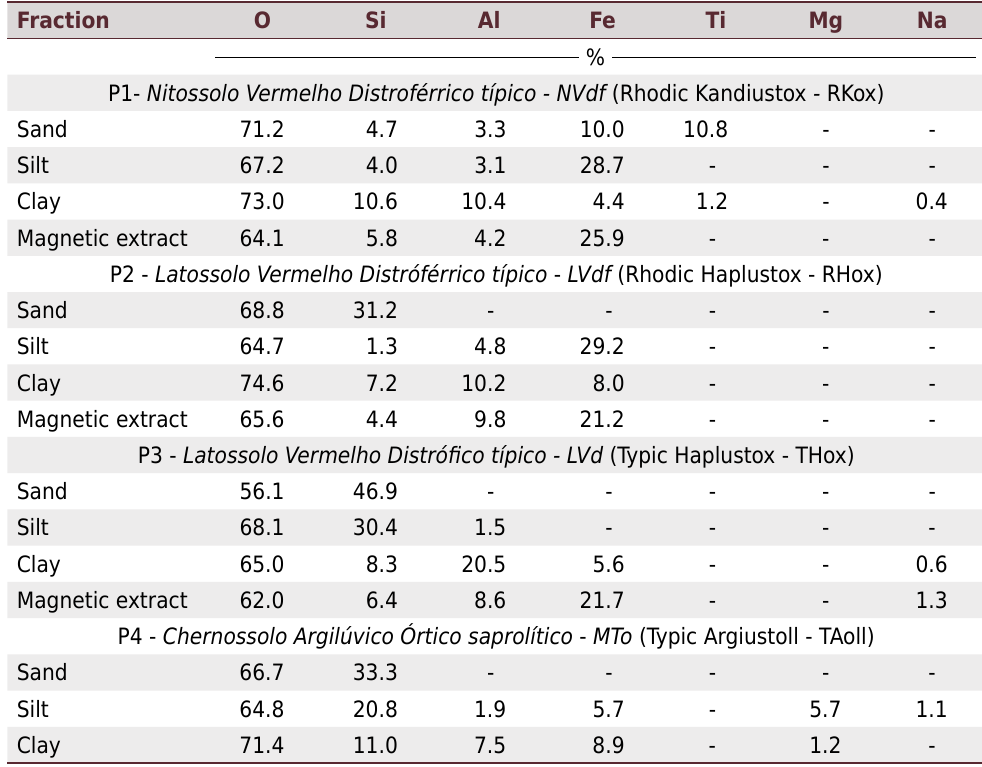
Table 6. Major elemental chemical composition for the sand, silt, and clay fractions from diagnostic horizons of the soils from the Southern Espinhaço Mountain Chain and Upper Jequitinhonha Valley, as obtained by dispersive energy